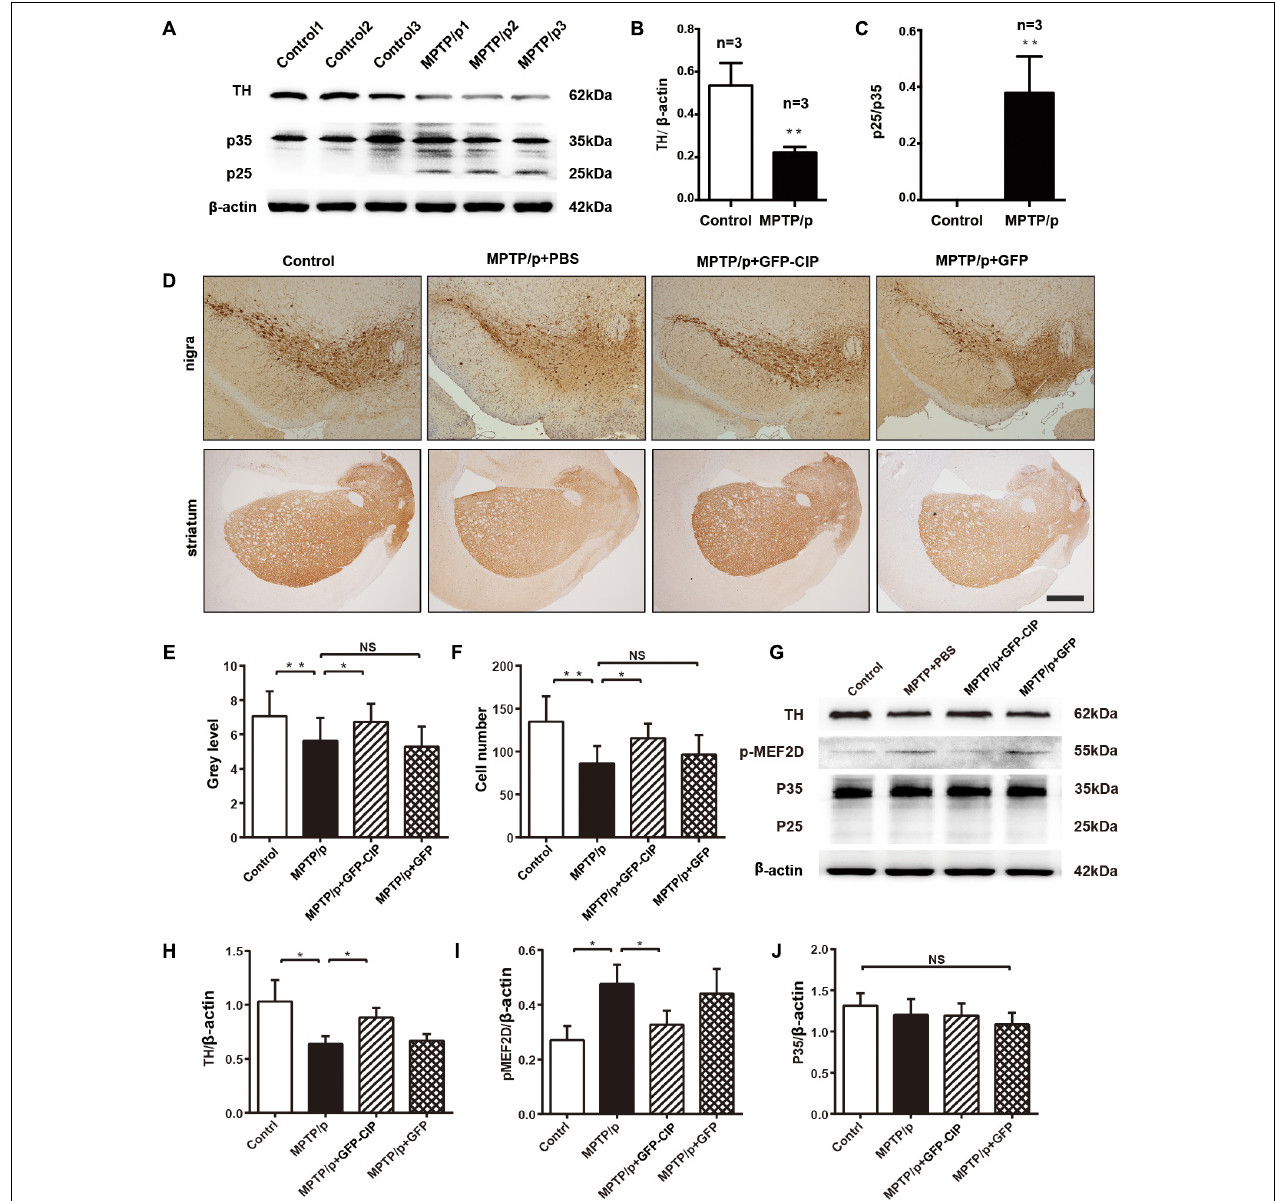
FIGURE 3 | AAV9-GFP-CIP reduced DA neuronal loss and the level of phosphorylated MEF2D in MPTP/p mouse model. Mice were administrated with PBS, AAV9-GFP-CIP, or AAV9-GFP via intracerebroventricular injection 1 week before MPTP/p insult. The MPTP/p induced PD model was established by subcutaneously injection of 100 µ l of MPTP (25 mg/kg) daily for 10 days and intraperitoneally injection of 100 µ l of probenecid (250 mg/kg ) twice per week for 5 weeks. (A) Western blot analysis of brain lysates from mice administrated with MPTP/p or PBS control mice were performed using anti- β -actin, anti-p35 (detection of C-terminus of p35), and anti-tyrosine hydroxylase (TH) primary antibodies. Protein sizes were indicated along the right side. (B) Relative ratio of TH intensity per β -actin intensity. The relative level of tyrosine hydroxylase was significantly decreased in MPTP/p induced mice compared to control mice ( p < 0.05). (C) Relative ratio of p25 intensity per p35 intensity. A high level of p25 was detected in MPTP/p mouse model, while there was no p25 detected in control mice ( n = 3). (D) Immunohistochemistry images of midbrain striatum and substantia nigra from control group, PBS group, GFP group, and CIP group mice. The sections were incubated with anti-TH primary antibody and goat anti-rabbit secondary antibody. (E) The mean density of TH in striatum from immunohistochemistry. The mean density of TH in the PBS group (5.638 ± 0.33 n = 6) was decreased when compared to the control group (7.074 ± 0.40 n = 6, ∗∗ p < 0.01). The alteration was alleviated in GFP-CIP treatment group (6.725 ± 0.30 n = 6), compared to PBS treated group ( ∗ p < 0.05), while there was no difference between PBS treated group and GFP treated group (5.286 ± 0.34 n = 6), labeled NS. (F) The number of TH positive neurons in nigra from immunohistochemistry. Neurons were significantly decreased in MPTP/p+PBS group (86.17 ± 8.31 n = 6), compared to control group (134.7 ± 12.06 n = 6, ∗∗ p < 0.01). The TH positive neurons were significantly restored in CIP treated group (115.5 ± 6.93 n = 6, ∗ p < 0.05). No difference was observed between the GFP (96.33 ± 9.36 n = 6) group and PBS group (86.17 ± 8.31), labeled NS. (G–J) Western blot analysis of phosphorylated MEF2D. p-MEF2D was immunostained with anti-p-MEF2D and goat anti-rabbit secondary antibody. The phosphorylation of MEF2D was significantly increased in the PBS and GFP group, and decreased in the CIP group when compared to the PBS group ( ∗ p < 0.05 n = 3).